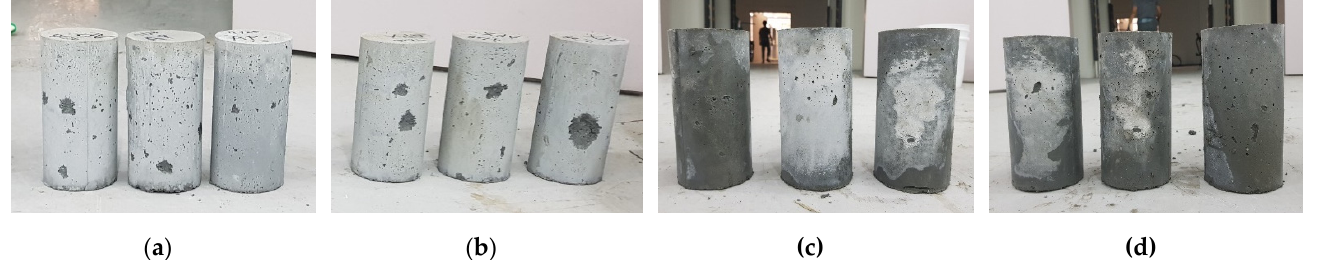
Figure 12. Specimens produced by direct casting in cylindrical molds after demolding: ( a ) AP-M-O; ( b ) AP-M-X; ( c ) WP-M-O; ( d ) WP-M-X.